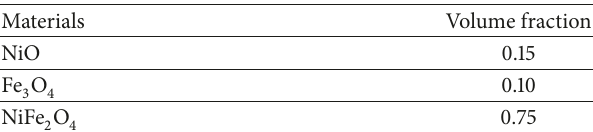
Table 2: Volume fractions of crud solid structure assumed in this study [11].